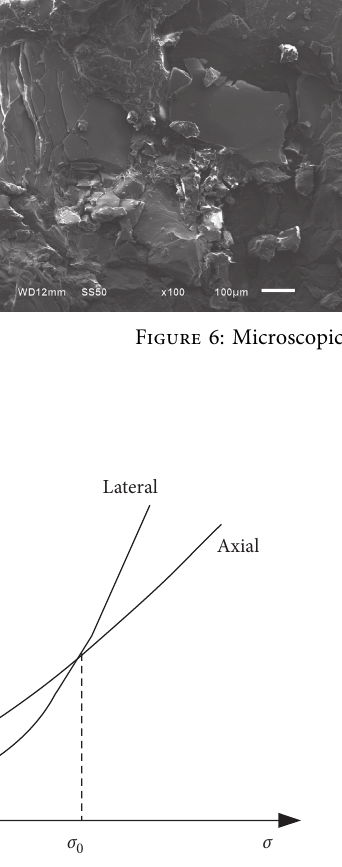
Figure 7: Schematic diagram of “intersection point of creep rate curve method.”